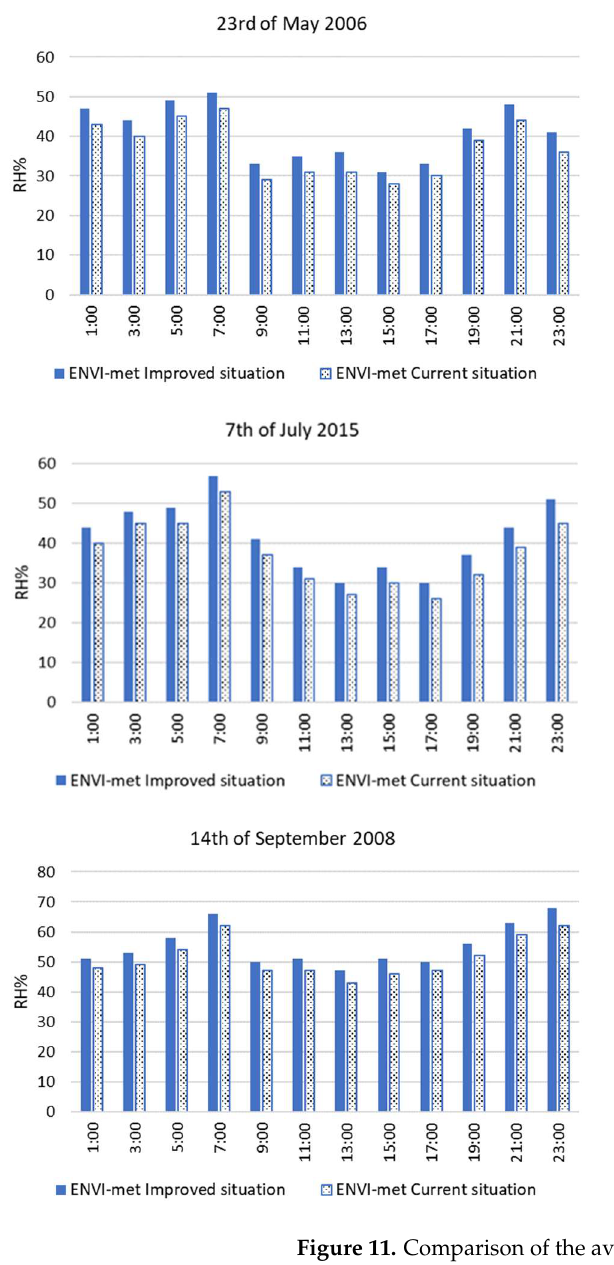
Figure 11. Comparison of the average relative humidity (RH) for the existing v. amended case study.